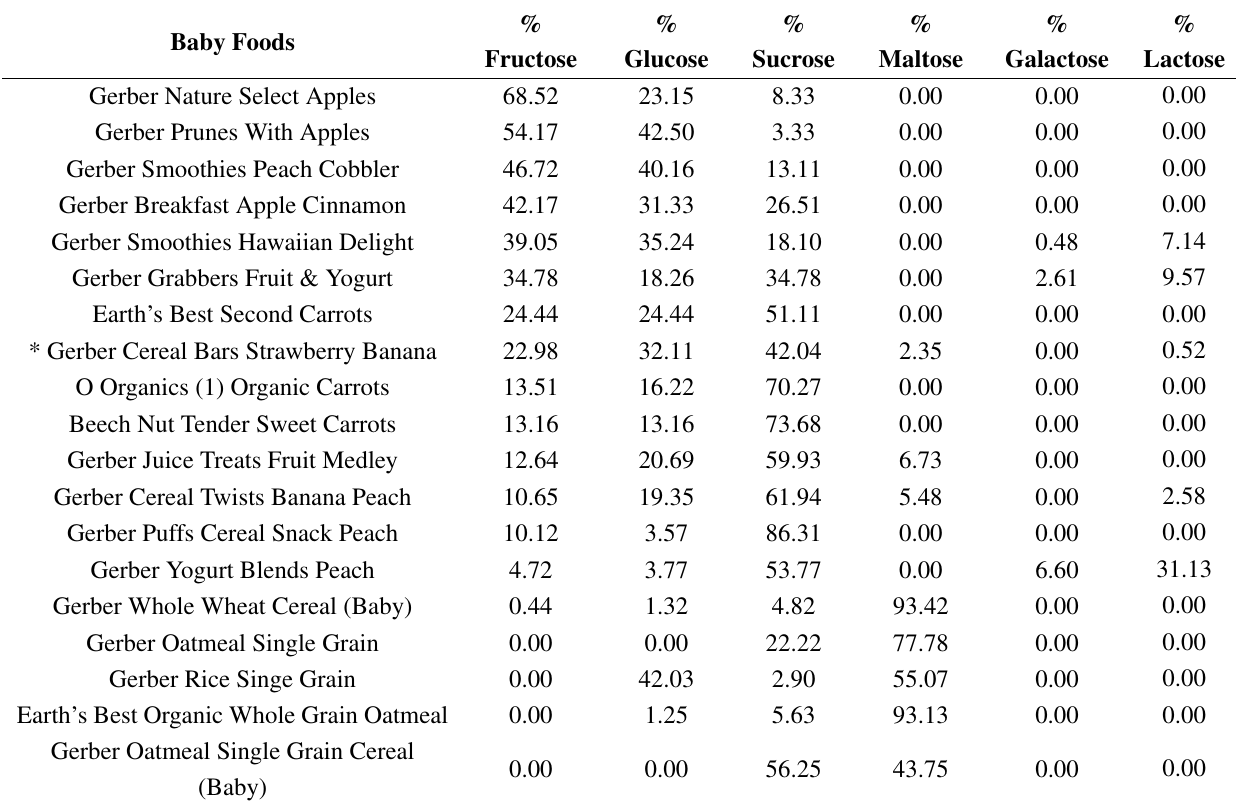
per serving ˆ 4)/Total Actual